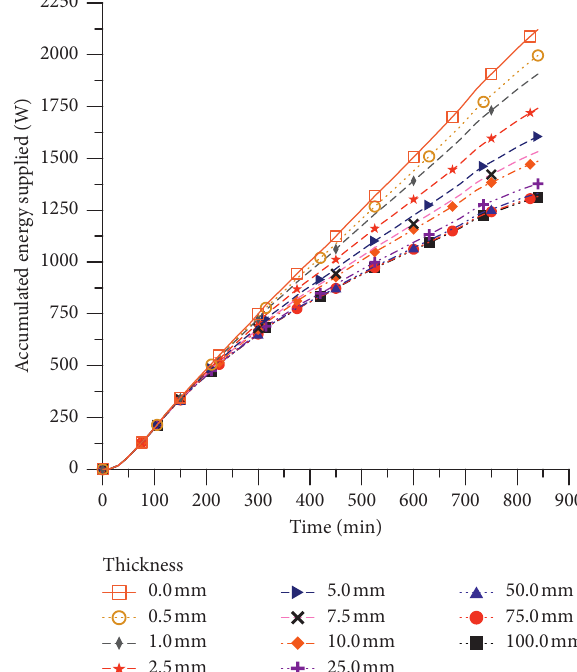
Figure 14: Accumulated energy supplied to the kiln during the heating process for different ceramic fiber thicknesses.